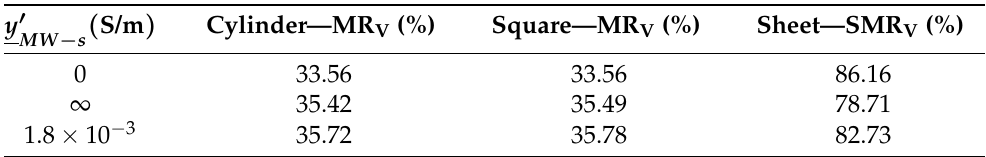
Table 3. Voltage mitigation rate yielded by different values of the mitigation wire p.u.l. admittance to earth y (cid:48) . MW − s